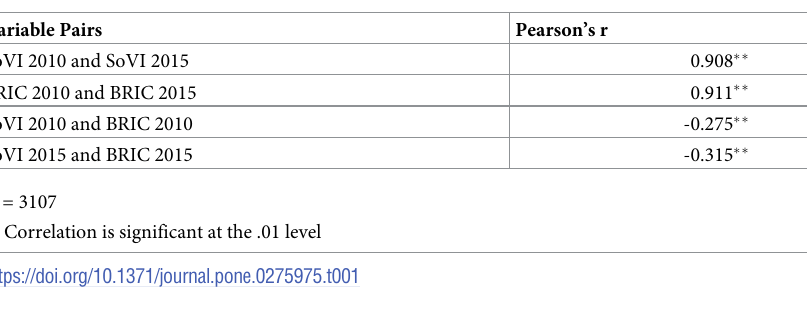
Table 1. Pearson correlation test results between SoVI and